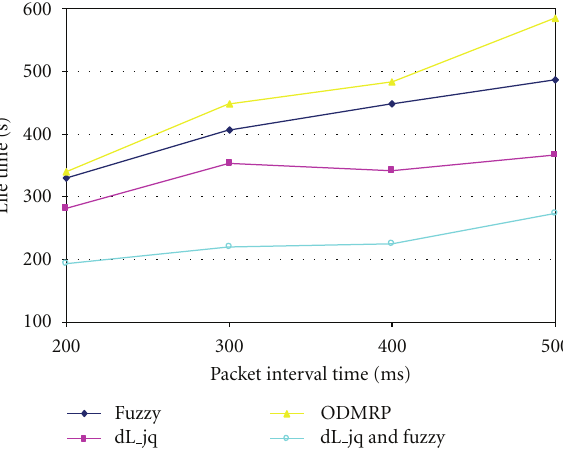
Figure 17: Life time with increasing packet interval